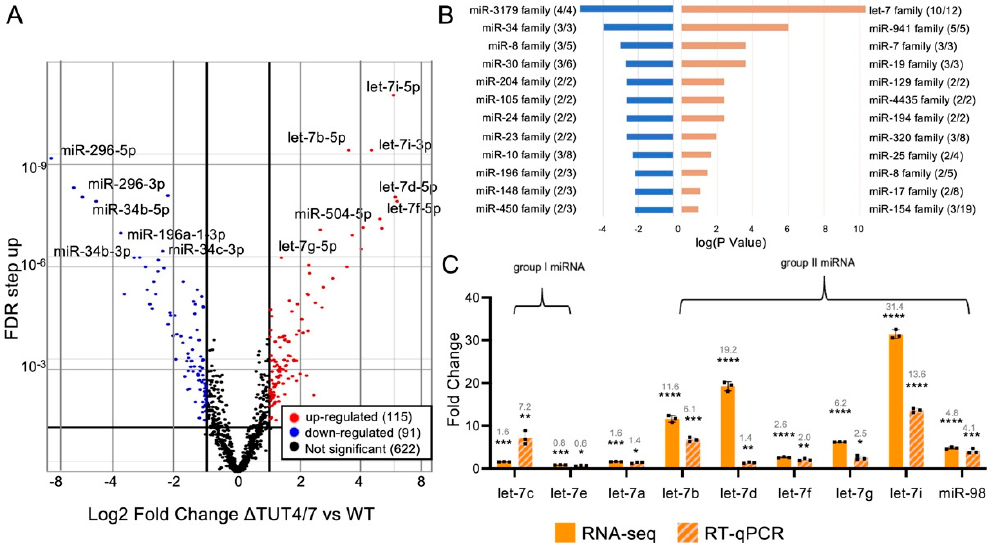
Figure 2. MicroRNAs are differentially expressed in HEK 293T cells lacking TUT4/7. ( A ) Volcano plot of miRNA expression plotting log2 fold change, in Δ TUT4/7 relative to wild-type HEK 293T cells, versus false discovery rate (FDR). Significantly (FDR ≥ 1, log2FC ≥ 1 or ≤ − 1) changed miRNAs are indicated in red (upregulated, 115 miRNAs),blue (downregulated, 91 miRNAs) or not significantly changed miRNAs in black (622 miRNAs). ( B ) Bar graph representing the results of a microRNA family set analysis using TAM2.0, showing numerous miRNA families are enriched in significantly up- (orange) and downregulated (blue) miRNAs. Enrichment is expressed as log ( p value) of the significance for miRNA enrichment. ( C ) RNA sequencing (orange) and RT-qPCR (orange and grey hashmarks) analysis reveal the different regulatory patterns between group I and group II let-7 miRNAs in Δ TUT4/7 cells: group I let-7 miRNAs have relatively small changes in expression in Δ TUT4/7 cells, while most group II let-7 miRNAs are drastically upregulated. Let-7a is encoded at multiple genomic locations as both group I and group II pre-miRNAs. All fold change values are shown relative to wild-type miRNA expression levels. Significance was calculated by Partek gene-specific analysis (GSA) (RNA-seq) or Student’s t -test (RT-qPCR) and is indicated by asterisks, where * p < 0.05, ** p < 0.01, *** p < 0.001, **** p < 0.0001.